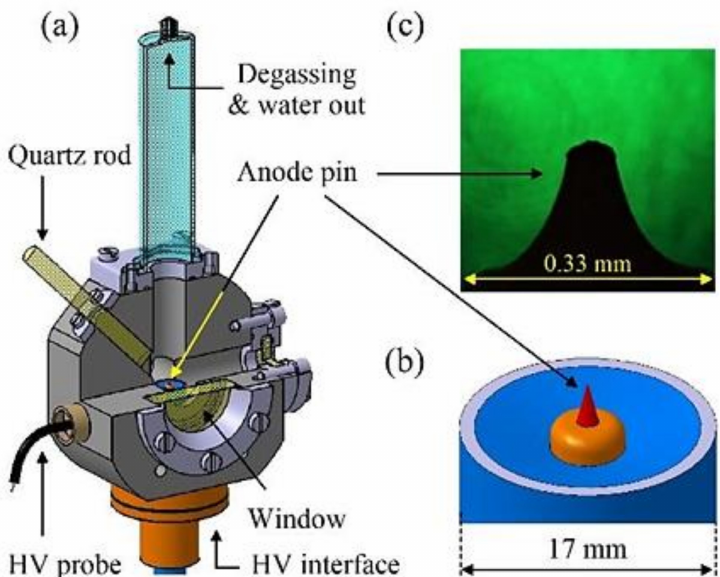
Figure 1. Simplified sketch of ( a ) the reactor chamber composed of a grounded stainless-steel body, fused silica windows for optical diagnostics, and a water inlet/outlet, ( b ) coax-based high-voltage (HV) electrode. Image ( c ) shows the tip of the anode pin used in this